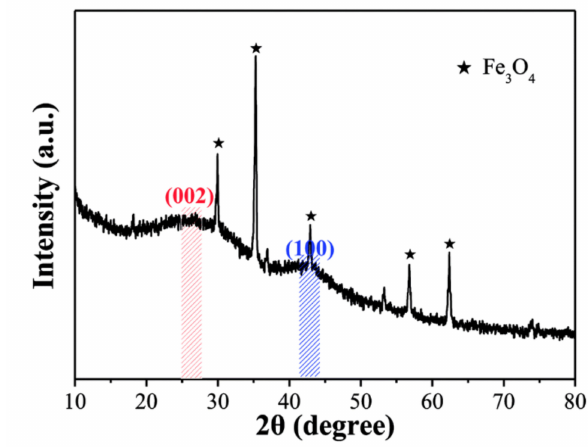
Figure 7. Standard XRD pattern of an activated carbon obtained through FeCl 3 chemical activation at 700 ◦ C (reprinted from [89], RSC,